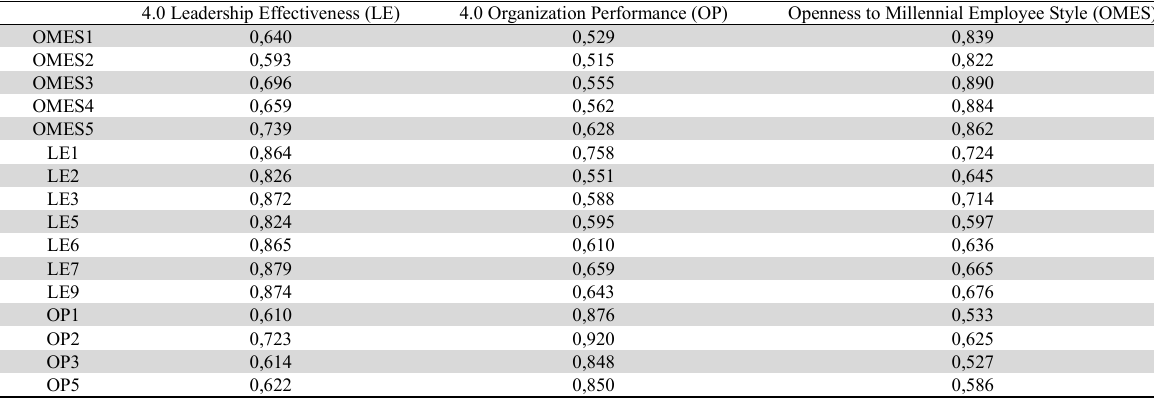
The matrix of loading and cross-loadings 4.0 Leadership Effectiveness (LE) 4.0 Organization Performance (OP)